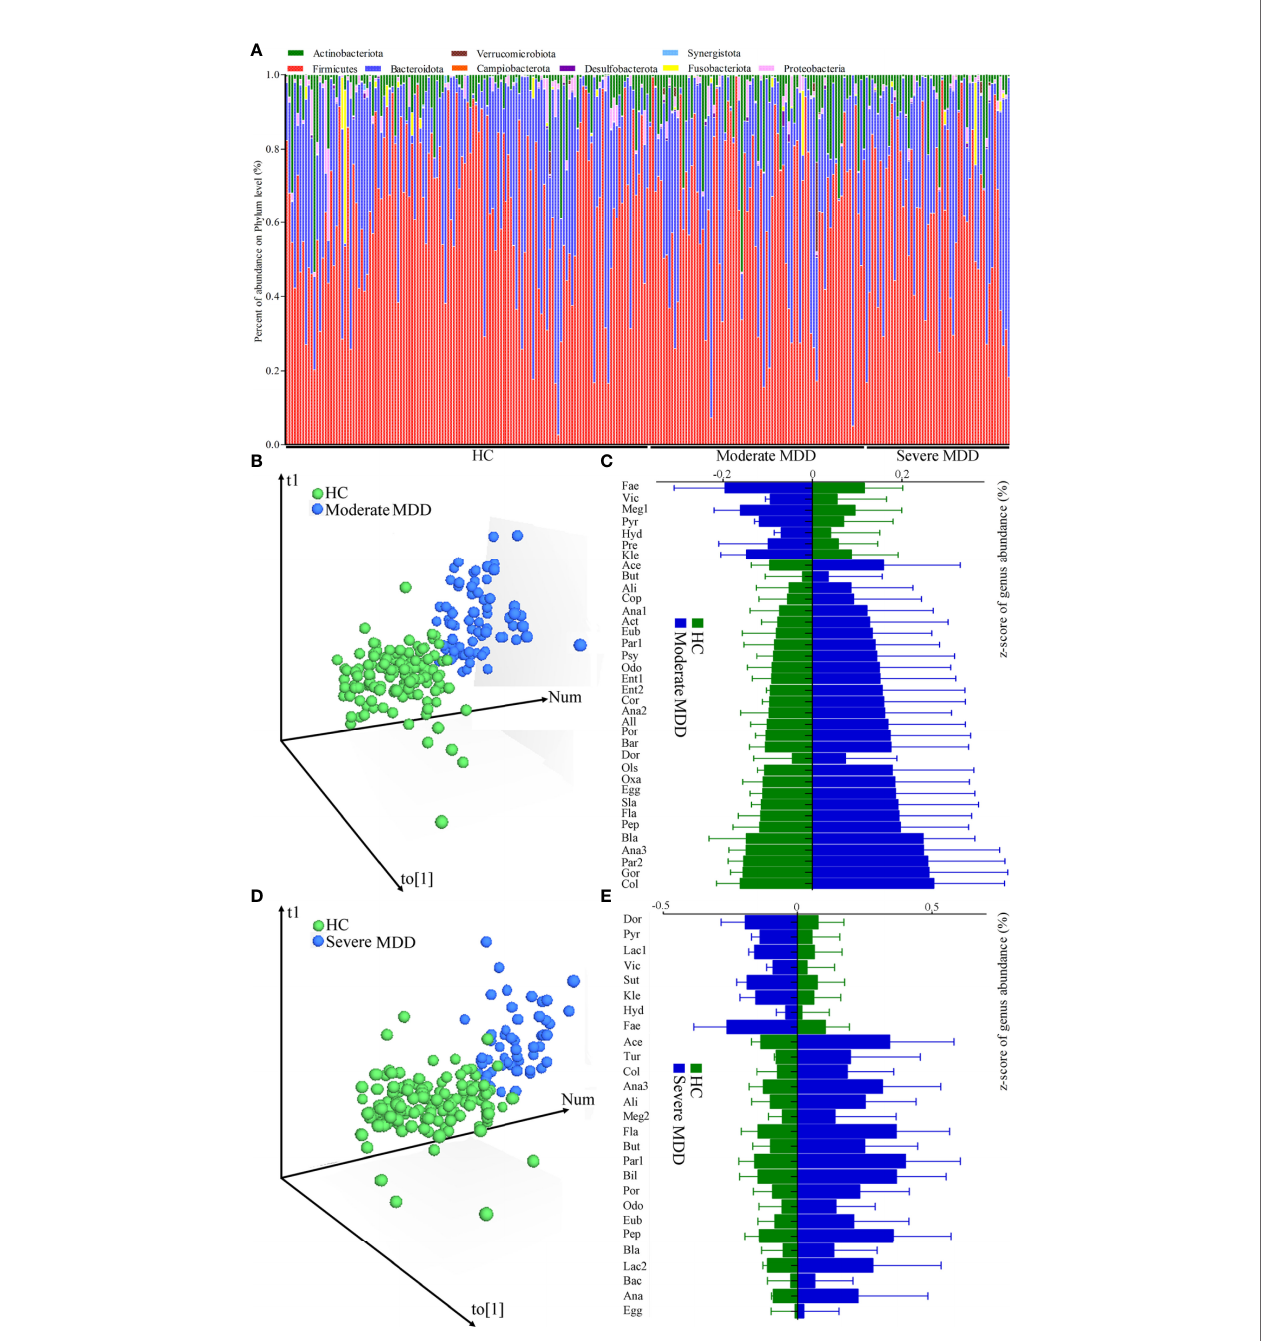
FIGURE 1 | Changes of gut microbiota compositions in HC and moderate and severe MDD patients. (A) Relative abundances of gut microbiota at the genus level in MDD patients and HC. (B) OPLS-DA model showed that there was only a small overlap between HC and moderate MDD patients, suggesting the divergent microbial changes between the two groups; (C) differential genera responsible for discriminating moderate MDD patients from HC; (D) OPLS-DA model showed that there was only a small overlap between HC and severe MDD patients, suggesting the divergent microbial changes between the two groups; (E) differential genera responsible for discriminating severe MDD patients from HC. HC, healthy controls; MDD, major depressive disorder; Fae, Faecalibacterium; Vic, Victivallis; Meg1, Megamonas; Pyr, Pyramidobacter; Hyd, Hydrogenoanaerobacterium; Pre, Prevotella; Kle, Klebsiella; Ace, Acetanaerobacterium; But, Butyricimonas; Ali, Alistipes; Cop, Coprobacillus; Ana1, Anaerococcus; Act, Actinomyces; Eub, Eubacterium; Par1, Parabacteroides; Psy, Psychrobacter; Odo, Odoribacter; Ent1, Enterococcus; Ent2, Enterorhabdus; Cor, Corynebacterium; Ana2, Anaerofustis; All, Allisonella; Por, Porphyromonas; Bar, Barnesiella; Ols, Olsenella; Dor, Dorea; Oxa, Oxalobacter; Egg, Eggerthella; Sla, Slackia; Fla, Flavonifractor; Pep, Peptoniphilus; Bla, Blautia; Ana3, Anaerotruncus; Par2, Parvimonas; Gor, Gordonibacter; Col, Collinsella; Lac1, Lactococcus; Sut, Sutterella; Tur, Turicibacter; Meg2, Megasphaera; Bil, Bilophila; Lac2, Lactobacillus; Bac, Bacteroides; Ana,